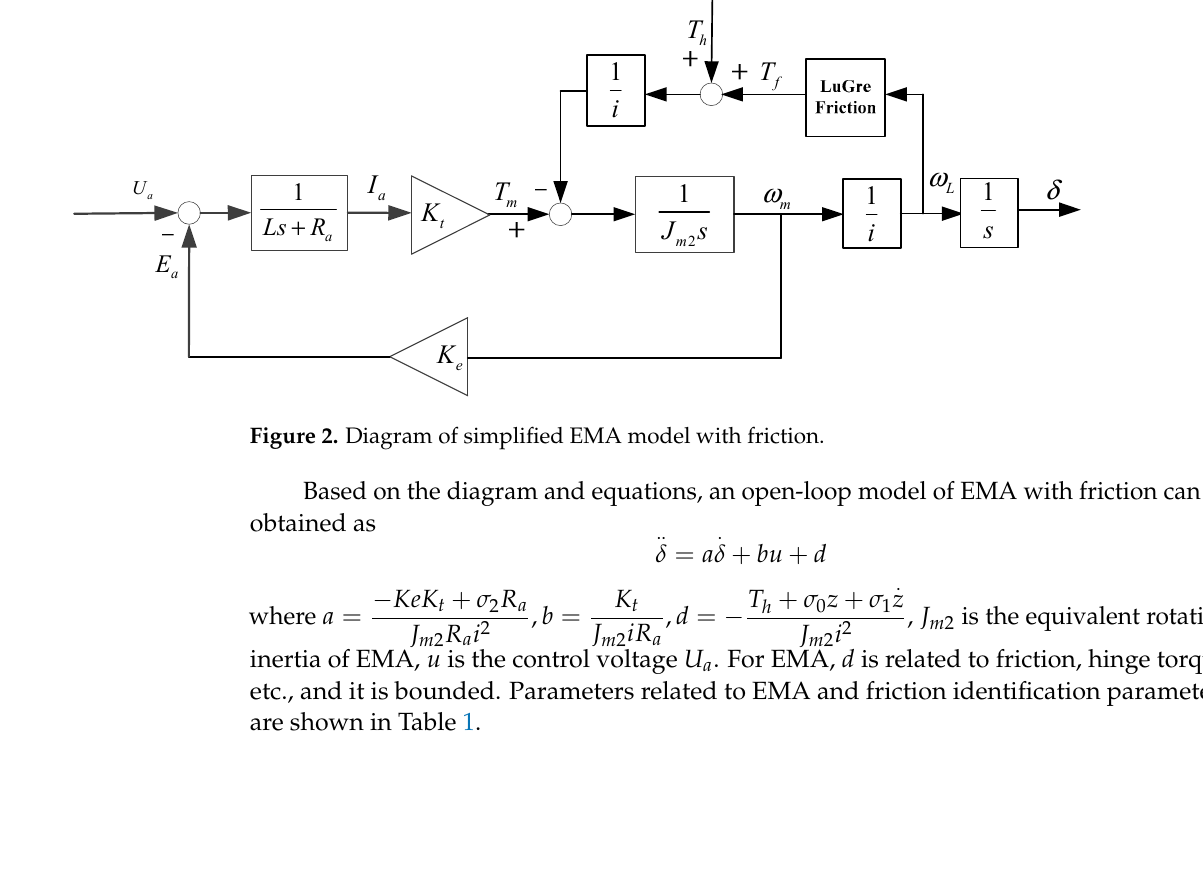
Table 1. EMA parameters.